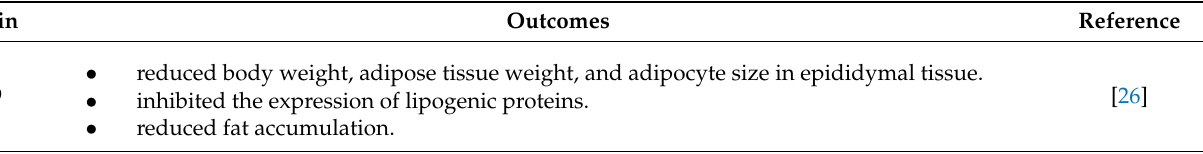
Table 1. Strains of L. reuteri cited in this review and their outcomes. Strain